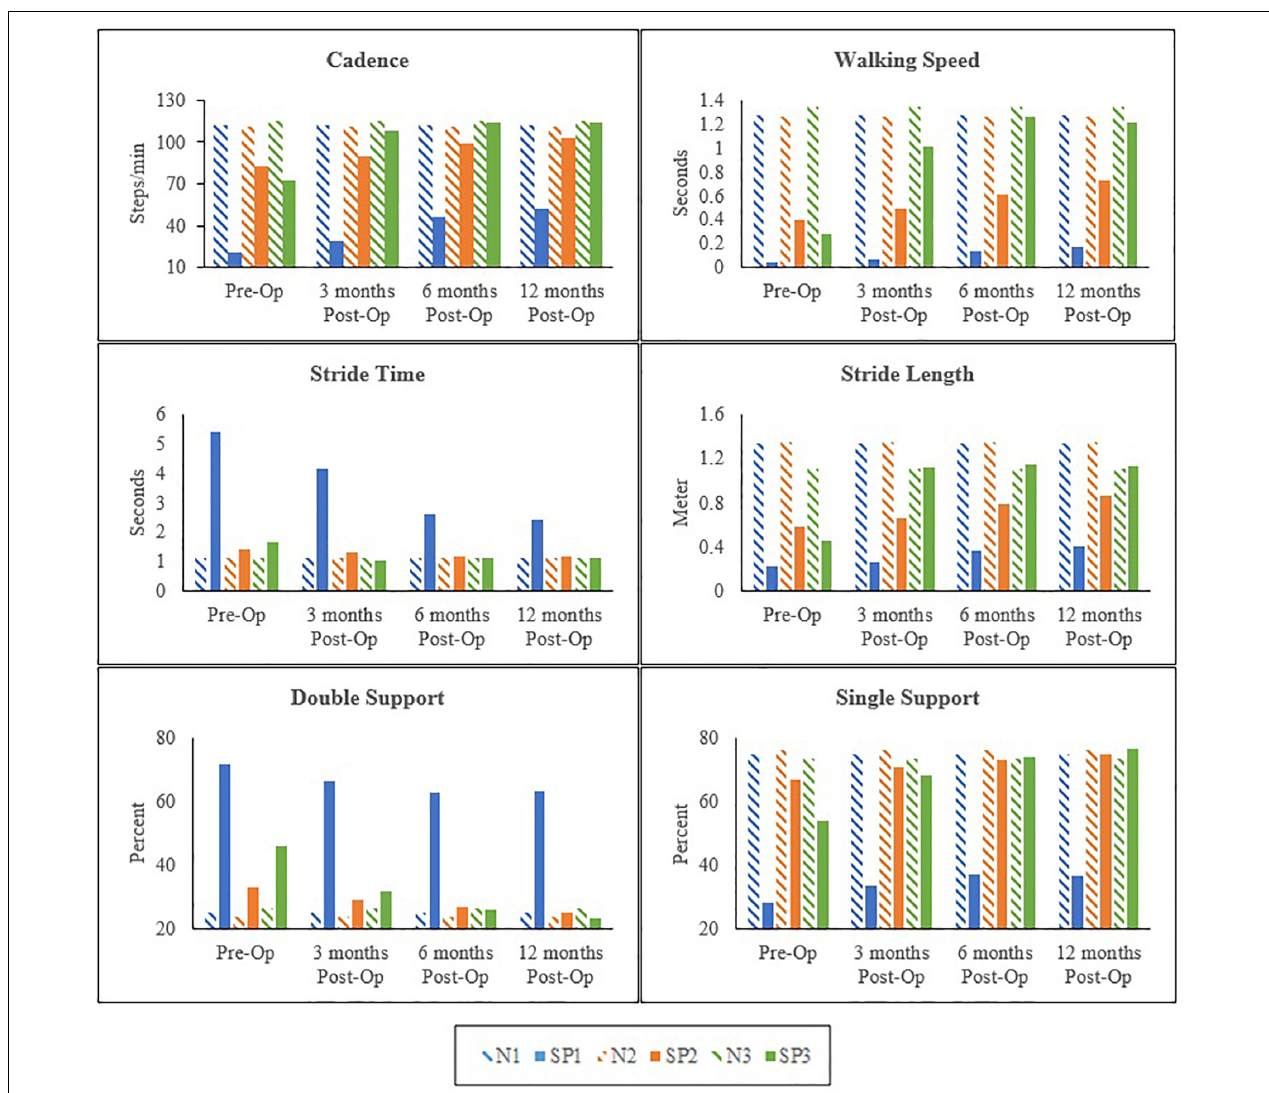
FIGURE 3 | Mean trends of hip and knee flexion-extension in the affected and sound side during gait cycle in spastic patient